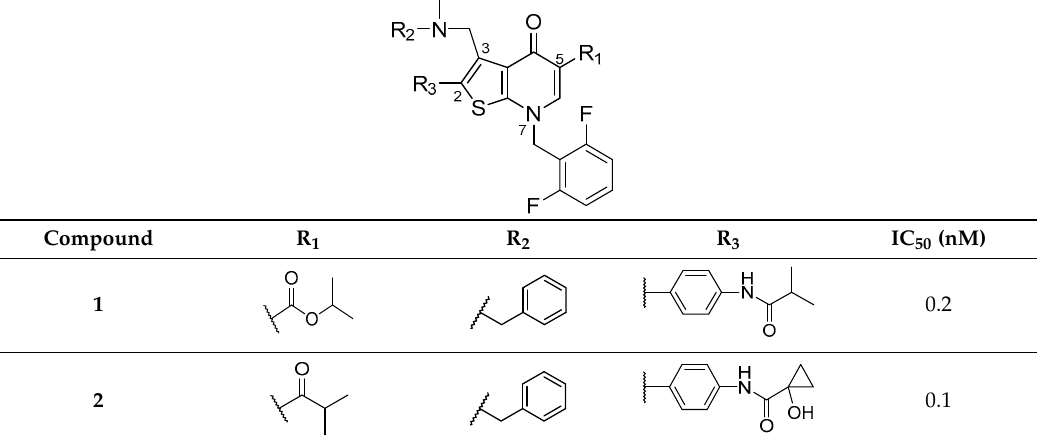
Table 1. Thieno[2,3- b ]pyridine-4-one derivatives and their binding affinities at human GnRH-R .